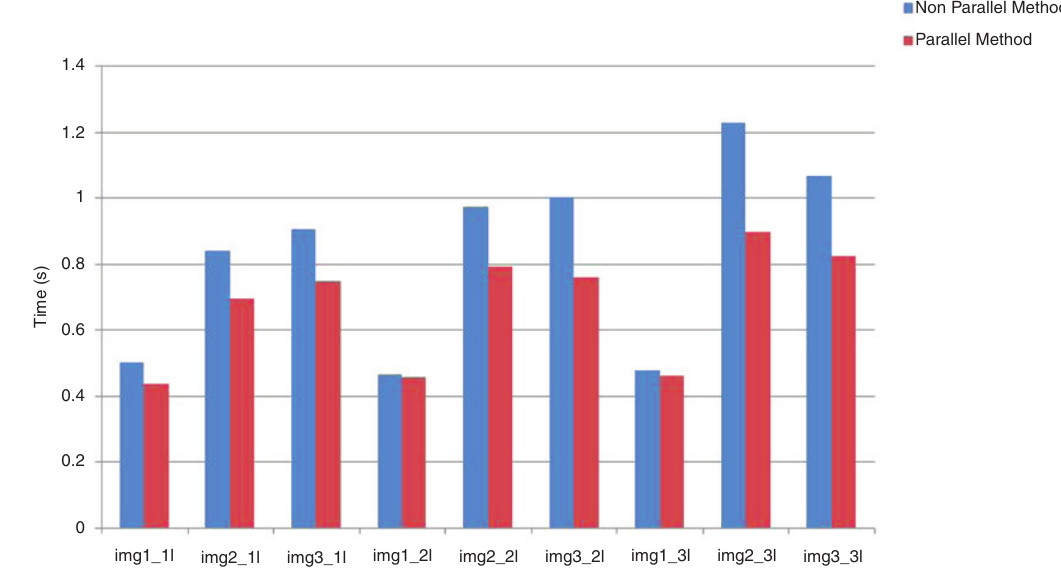
Figure 4: Comparative Study of Decompression